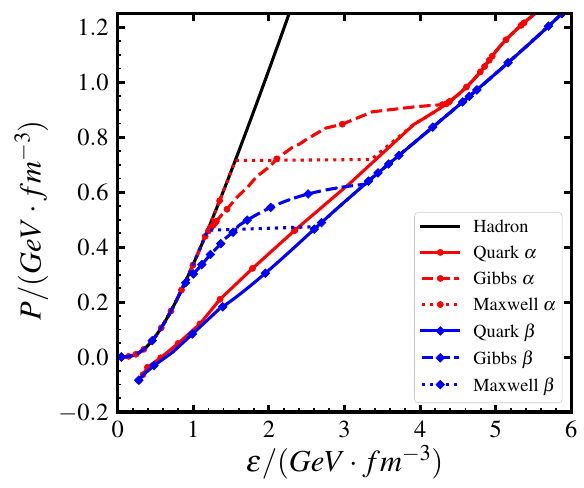
Fig. 8 Calculated equation of state. The black solid line is the result of the pure hadron matter via the TW-99 RMF model, the red lines with circle symbol stand for the results using the α -type modification, the blue lines with diamond symbol correspond the result implementing the β -type modification. The solid lines with symbols represent the results of the pure quark matter, the dashed lines with symbols correspond to the results via the Gibbs construction, and the dotted lines with symbols stand for the results with the Maxwell construction